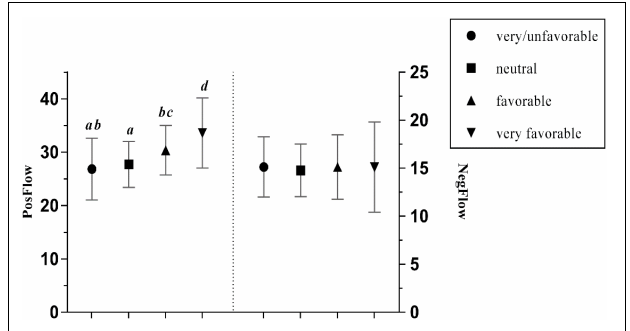
FIGURE 9 | The effects of students’ attitude toward the FL teacher on PosFlow and NegFlow (Means and significant Differences).